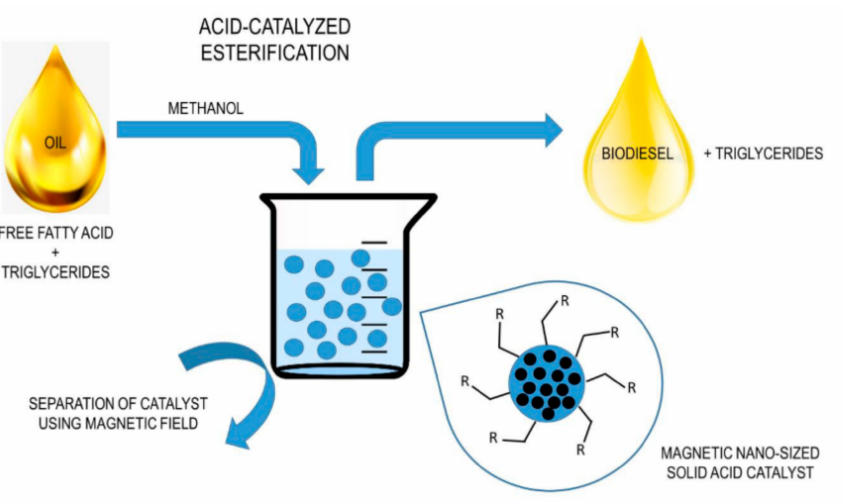
Figure 1. Biodiesel synthesis process using a magnetized solid acid-catalyzed esterification process